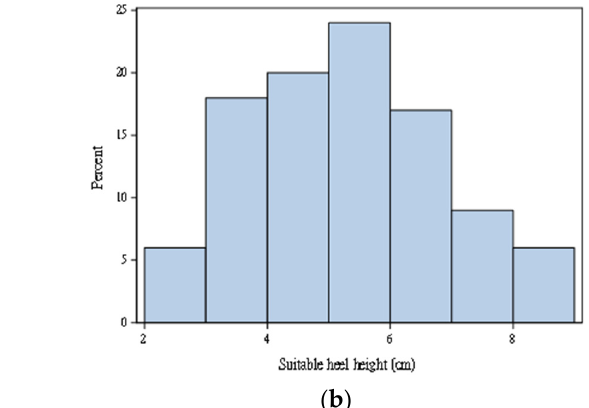
Figure 4. Sensor positions for left and right feet.